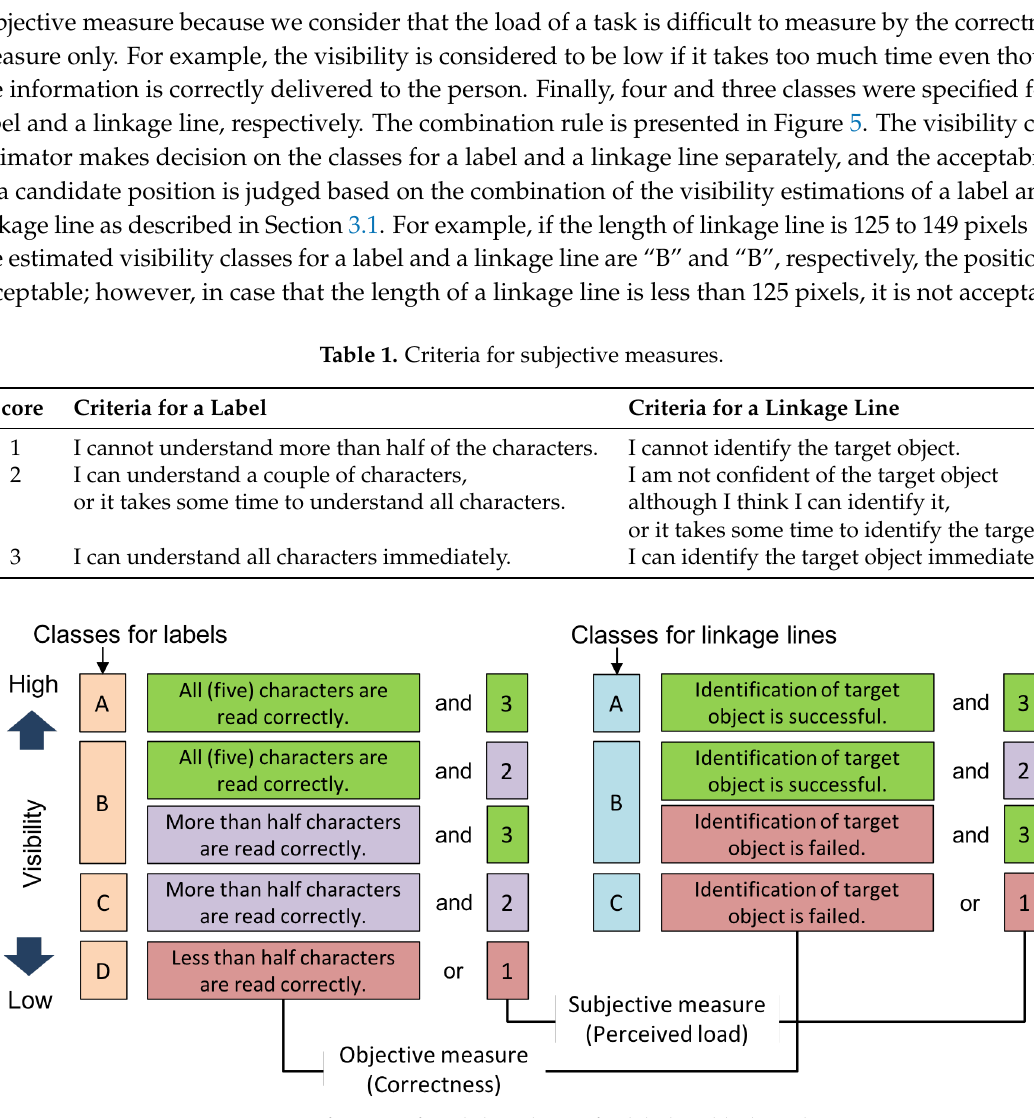
Figure 5. Definition of visibility classes for label and linkage